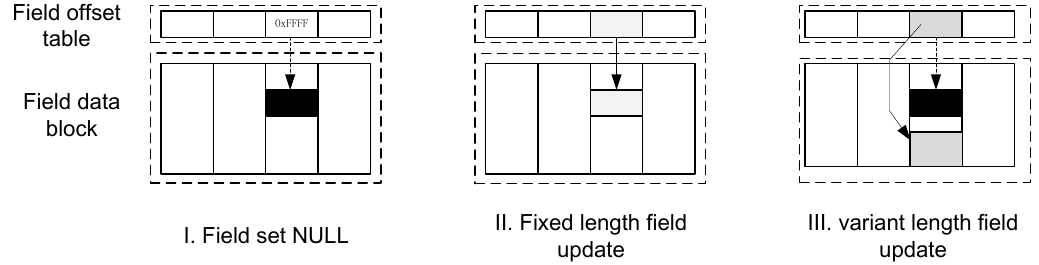
Figure 5. Field update mechanism in real-time data update method.